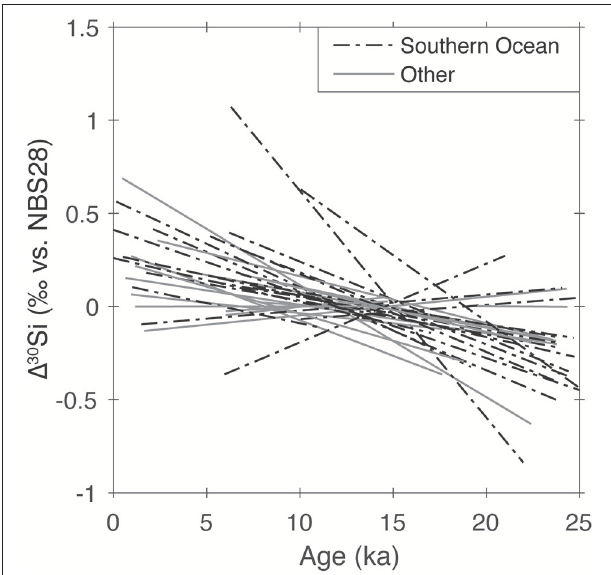
FIGURE 2 | Least-squares regression lines fit though sedimentary δ 30 Si bSiO2 records from 25 ka to present, standardized to mean δ 30 Si of the record: almost all records show an increase from the glacial to the Holocene, with an average trend of ca. 0.045 ‰ ka-1, suggestive of a common mechanism. Data are from Beucher et al. (2007), Brzezinski et al. (2002), De La Rocha et al. (1998), Doering et al. (2016), Ehlert et al. (2013), Ellwood et al. (2010), Hendry et al. (2010), Hendry et al. (2014), Hendry et al. (2012), Horn et al. (2011), Kim et al. (2017) , Maier et al. (2013), Panizzo et al. (2014), Pichevin et al. (2012), Pichevin et al. (2009), Sutton (2011), and Xiong et al. (2015).